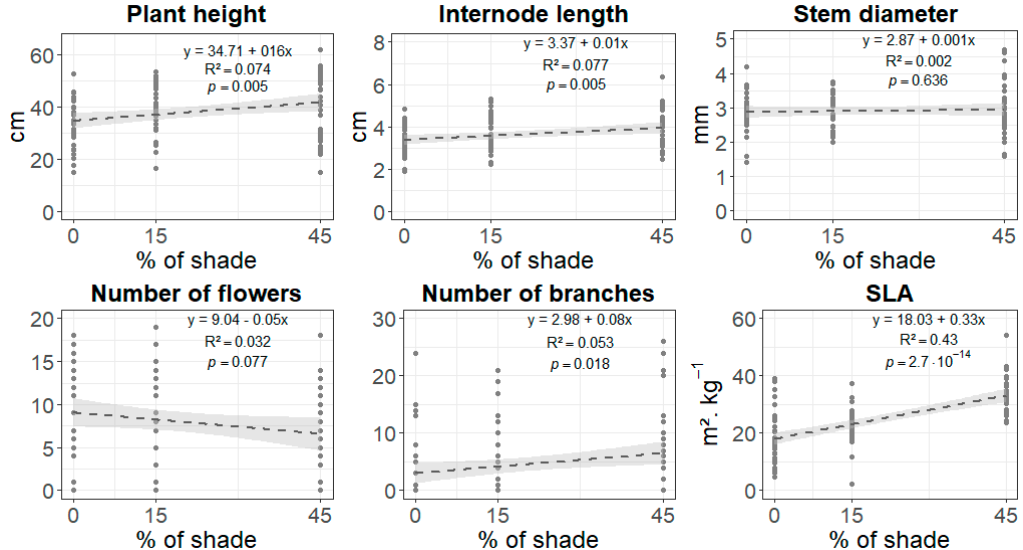
Figure 1. Shade avoidance response in Antirrhinum majus highly inbred lines. Linear relationships established by generalized linear models (GLMs) between phenotypic traits and shade. Phenotypic traits included plant height in cm, internode length in cm, stem diameter in mm, number of flowers, number of branches, and specific leaf area (SLA) in m 2 · kg − 1 . Shade treatments included 0%, 15%, and 45%. Equations, probabilities of significance ( p ), and coe ffi cients of determination ( R 2 ) are given for each relationship. N = 105 (five plants × three shade treatments × seven lines). The dotted line represents the regression line surrounded by its 95% confidence interval represented by the gray